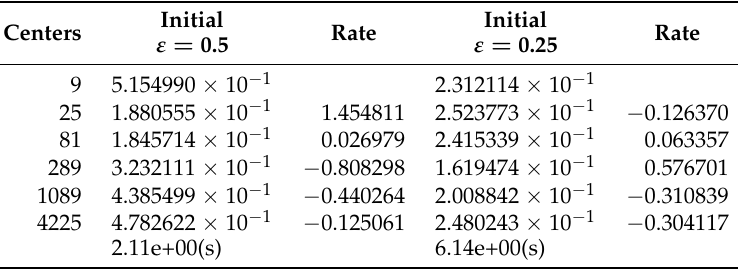
Table 6. CSRBFs collocation: